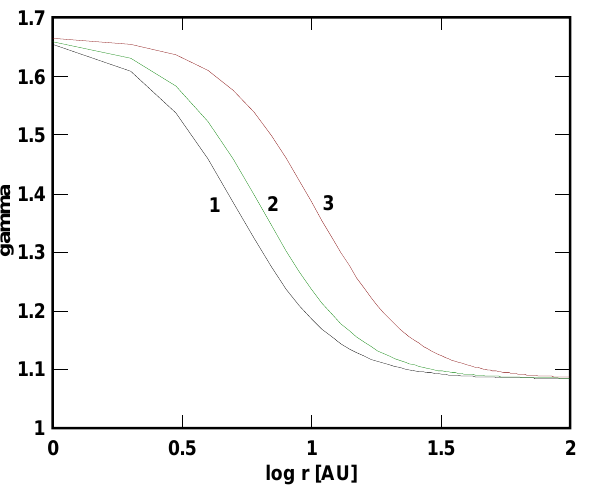
Fig. 5. Plotted is the polytropic index γ 1 versus the logarithm of the solar distance r at 1α = 50 and T 1 , 0 = 5 · 10 4 K for different values of 3 , i.e. for: 1: 3 = 1 · 10 − 3 , 2: 3 = 2 · 10 − 3 , 3: 3 = 3 · 10 − 3